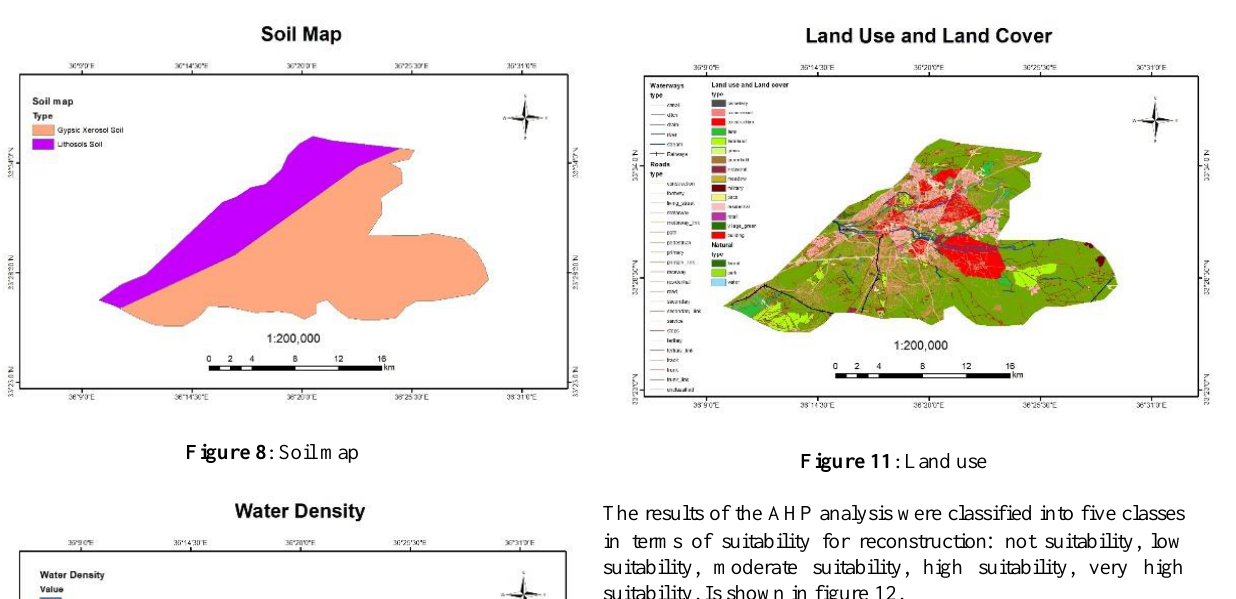
Figure 11 : Land use